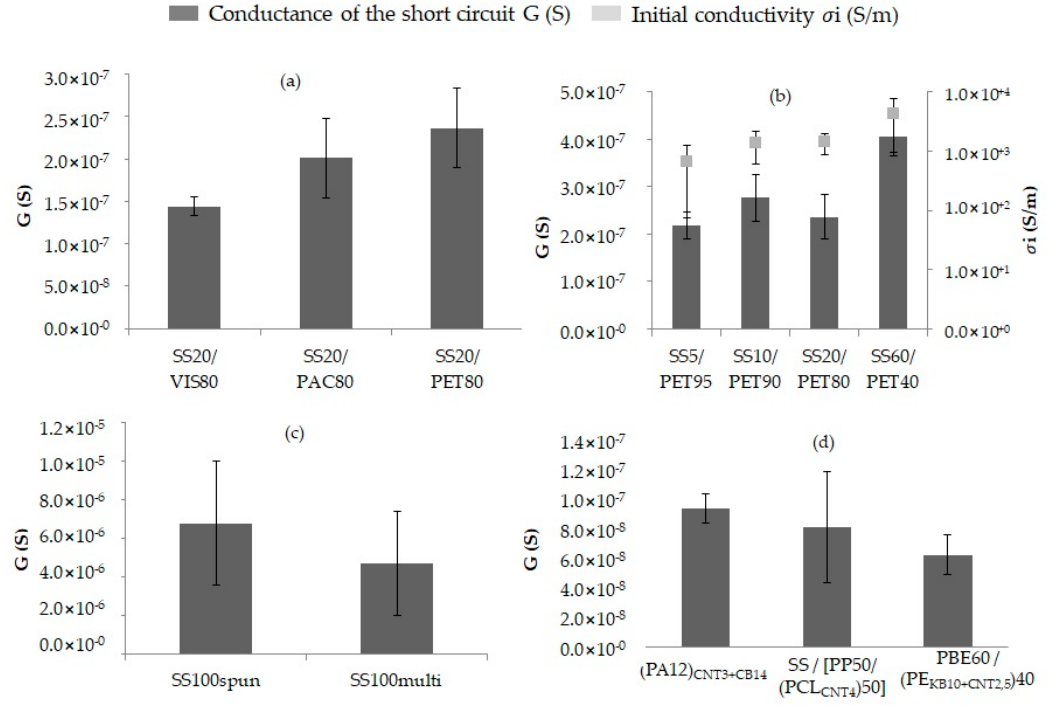
Figure 10. Short circuit: influence of di ff erent yarn properties on the signal: ( a ) the chemical nature of the non-conductive fibres in the blend, ( b ) the SS proportion by weight in the SS / PET blend-spun yarns, ( c ) the physical nature of two 100% SS yarns and ( d ) the formulation of di ff erent yarns in